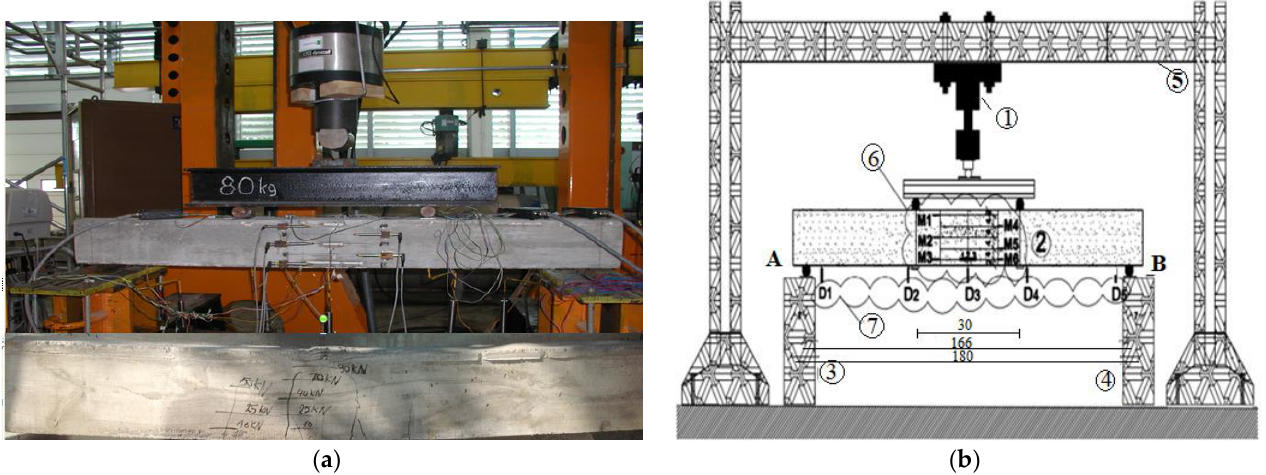
Figure 11. Scheme of the test rig for the beam of V-th series: 1 — actuator, 2 — the tested element, 3 — roller support, 4 — hinged support, 5 — main supporting frame, 6 — induction sensors measuring horizontal displacement, 7 — induction sensors measuring deflection.